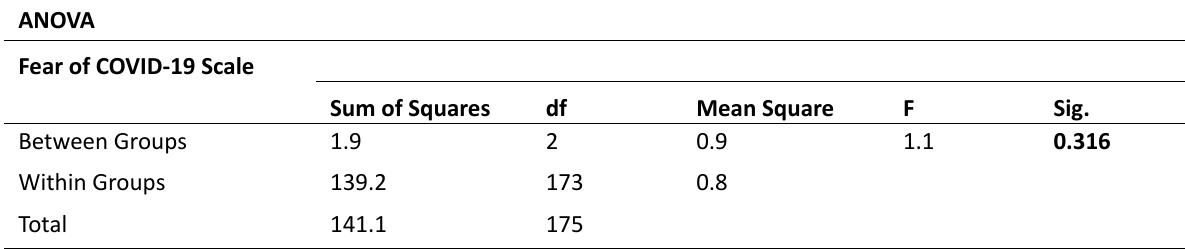
Table 4. One-Way ANOVA Test Results According to the Contact Variable Contained by the Specialization Sports ANOVA Fear of COVID-19 Scale Sum of Squares df Mean Square F Sig. Between